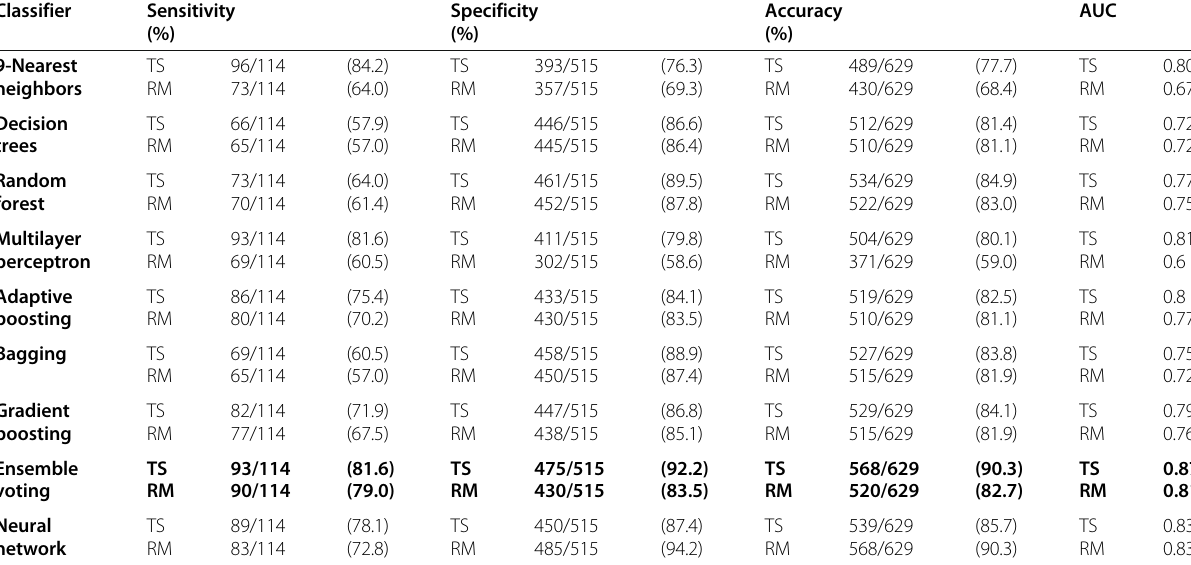
Table 4 Comparison of the classification results of the true microcalcifications as BI-RADS benign or suspicious using temporal subtraction (TS) of mammograms and using only the most recent mammograms (RM), in a leave-one-patient-out